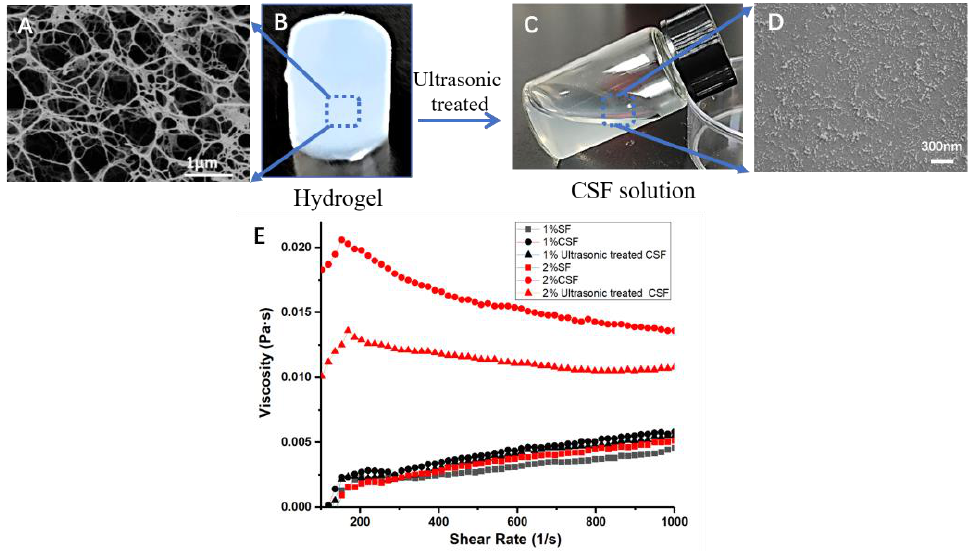
Figure 2. Morphology of silk fibroin in hydrogel ( A , B ) & CSF solution ( C , D ) and the viscosity of solutions ( E ).